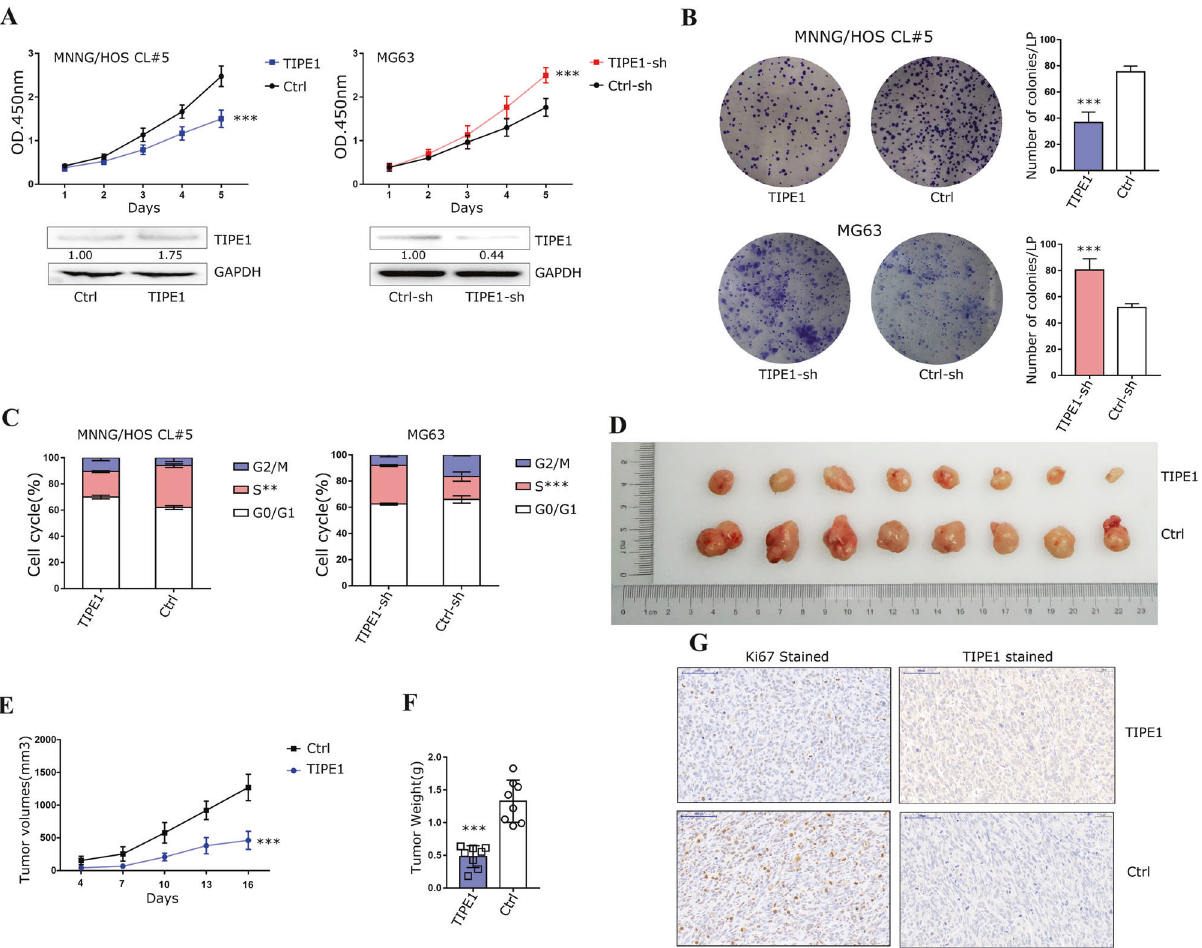
Fig. 2 TIPE1 inhibits osteosarcoma cell proliferation. A Cell growth curves obtained using the CCK-8 method showed that TIPE1 decreased the proliferation rate of osteosarcoma cells compared to the control. B Clone formation assays showed that TIPE1 decreased the number of clones by osteosarcoma cells. C Cell cycle progression assay suggested that TIPE1 reduced the proportion of cells in the S phase, as shown by propidium iodide staining and fl ow cytometry. D – F TIPE1 overexpression reduced tumor growth compared to control ( n = 8 mice/group), including tumor volumes and weight, in vivo. G TIPE1 overexpression downregulated the expression of Ki67 in xenograft tumor tissues, as determined by using immunohistochemical staining. *** P < 0.001, ** P < 0.01. The data represent the means ± SDs of 3